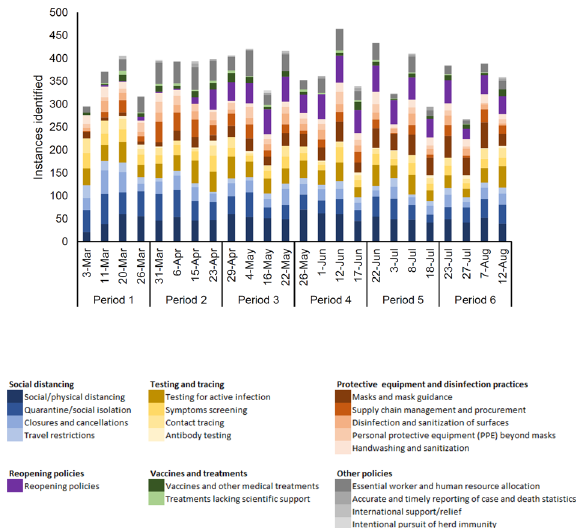
Fig. 7 The public-health policies and measures mentioned in news media articles analyzed over the timeframe of this study. Sampled articles ( n = 1331) were published on randomly sampled days between 1 March and 15 August 2020 (Methods). Public-health policies and measures in each article were coded under speci fi c categories related to social distancing, testing and tracing, protective equipment and disinfection practices, reopening policies, vaccines and treatments, and more (all relevant categories selected for each